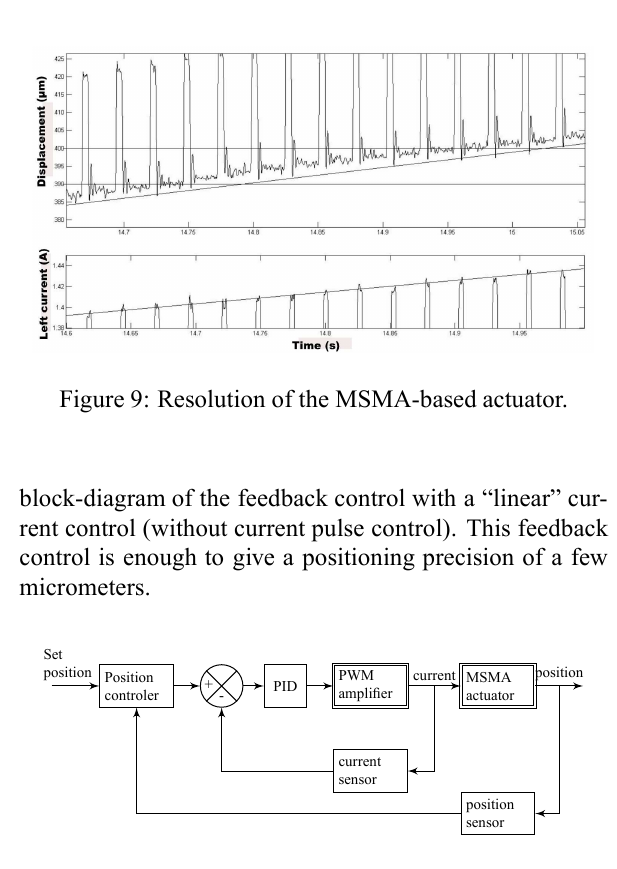
Figure 10: Block-diagram of the feedback control of MSMA-based actuator with a “linear” current